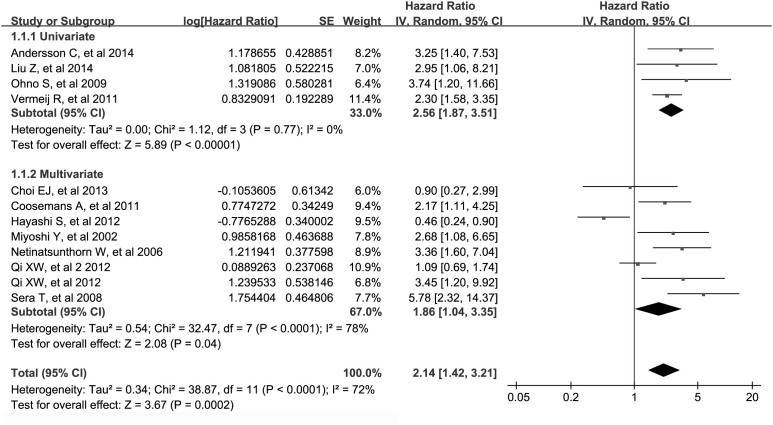
Meta-analysis of impact of WT1 expression on disease-free survival/progression-free survival/relapse or recurrence-free survival of patients with solid tumors.Results are presented as individual and metaHR, and 95% CI.